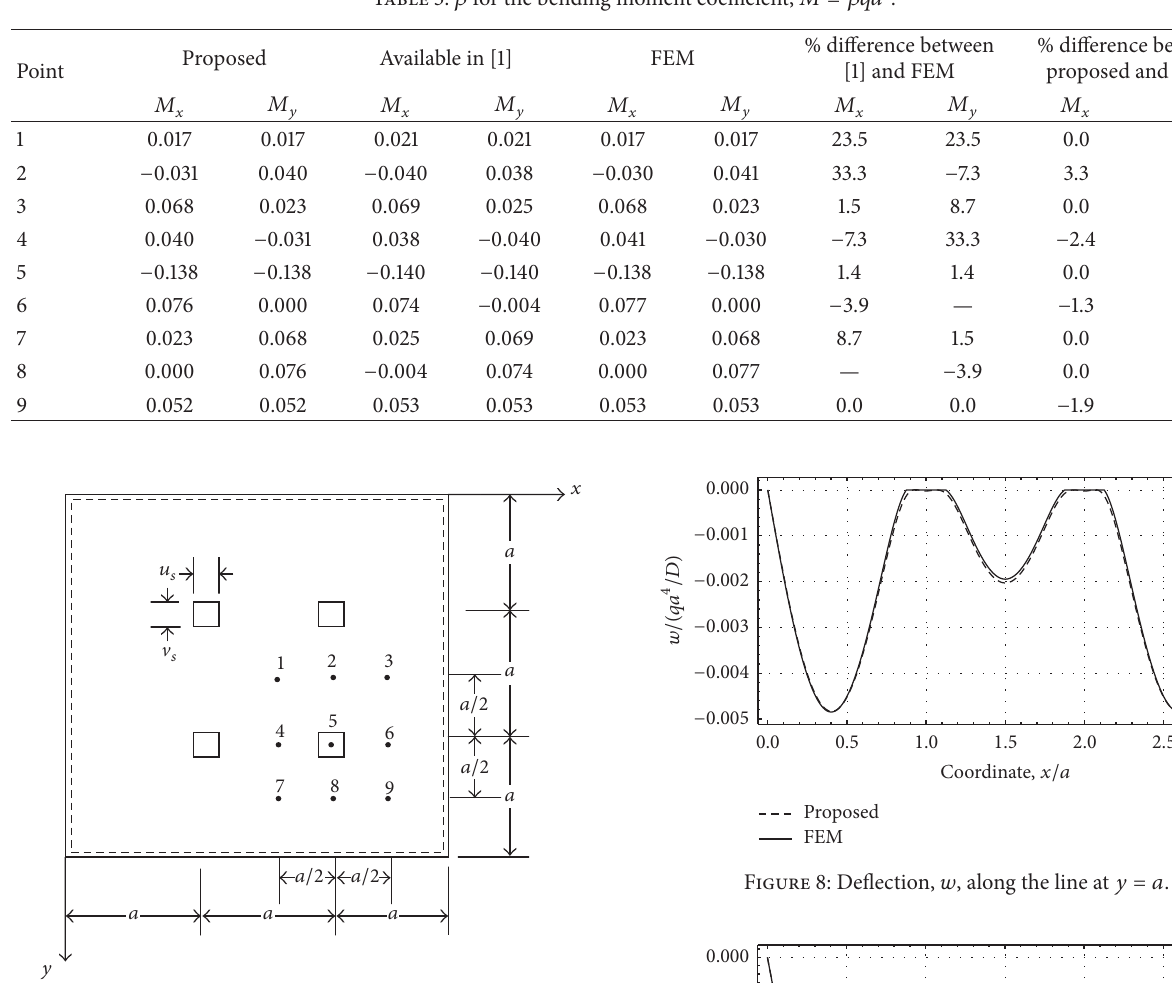
Table 3: 𝛽 for the bending moment coefficient, 𝑀 = 𝛽𝑞𝑎 2 .